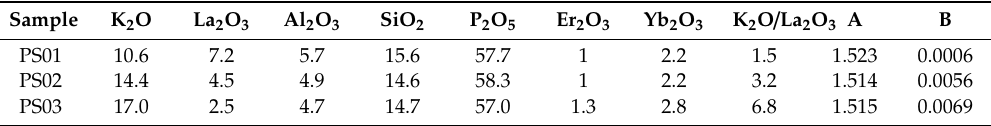
Table 1. Molar composition (mol · %), and K 2 O / La 2 O 3 molar compositional ratio of the samples as determined from XRF; and the corresponding Cauchy coe ffi cients (A and B) for the refractive index as determined from the ellipsometric